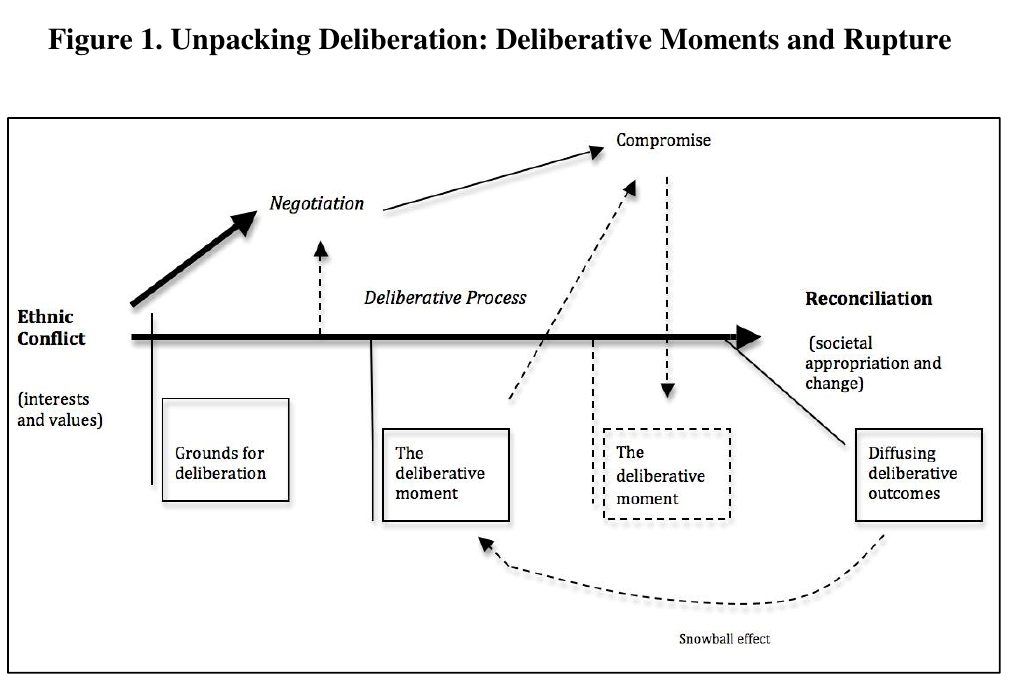
Figure 1. Unpacking Deliberation: Deliberative Moments and